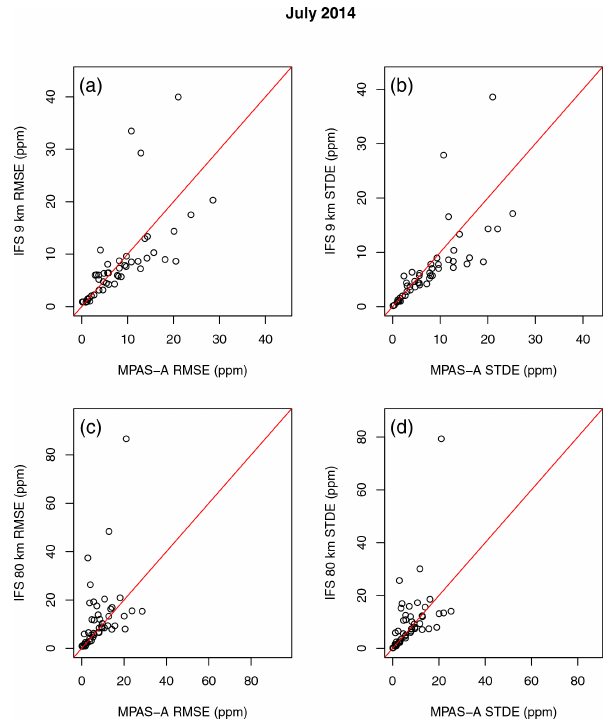
Figure 6. Same as Fig. 5 but for July 2014. Table 9. The duration of four ACT aircraft campaign